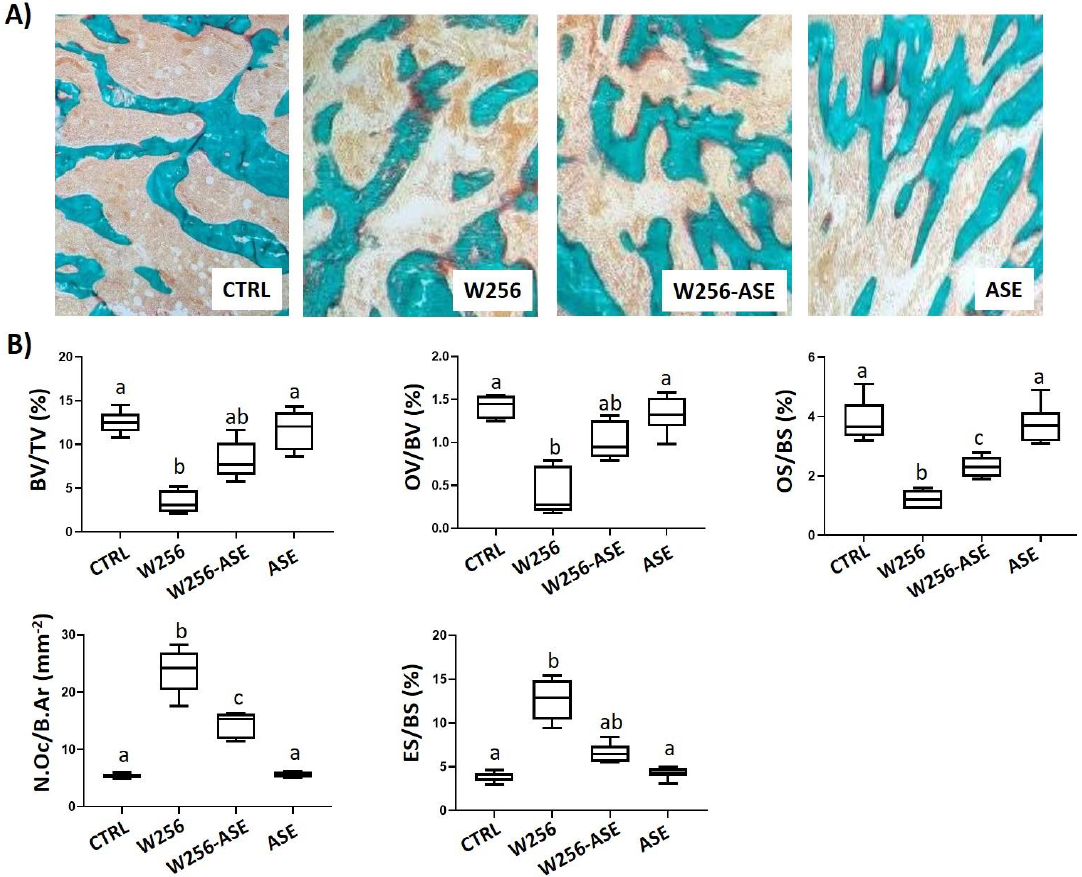
Figure 5. ( A ) Bone histological sections of the distal operated femurs from CTRL, W256, W256-ASE and ASE groups 20 days after surgery. The sections were stained with Goldner Modified Trichrome. W256 / B slide exhibits cancellous and trabecular osteolysis once compared with CTRL and ASE. The inter-trabecular spaces are occupied with both hematopoietic cells together with tumor foci due to Walker 256 / B cells’ inoculation. Note the alleviated trabecular network and bone quality in the W256-ASE histological section. Original magnification × 200. ( B ) Bone histomorphometric data for the distal operated femurs from CTRL, W256, W256-ASE and ASE. BV / TV: trabecular bone volume, OV / BV and OS / BS: osteoid volume and surface respectively, N.Oc / B.Ar: osteoclasts number per bone area, ES / BS: eroded surface. Values represent mean ± SD. Groups with di ff erent letters exhibit significant statistical di ff erence at least p < 0.05 following one-way ANOVA and Newman–Keuls post hoc